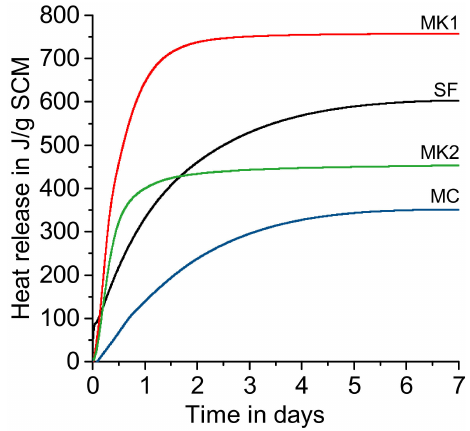
Figure 10. Results of the calorimetry test of R 3 samples.